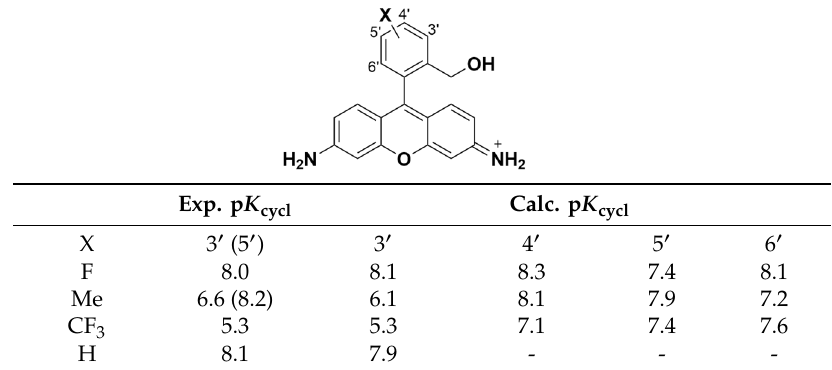
Table 2. Calculated and measured pK cycl values of HMRG derivatives substituted with various groups on the benzene moiety. R = H; X = O.